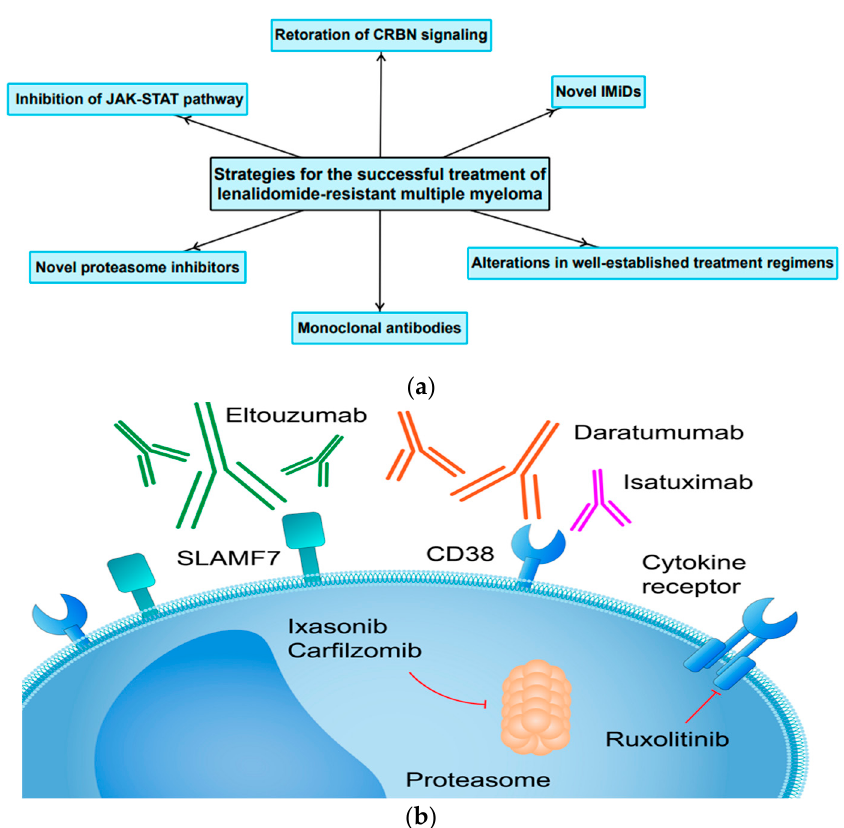
Figure 4. ( a ) The most important treatment strategies and future perspectives for the successful treatment LEN-resistant MM. ( b ) Molecular targets for novel agents successfully implemented in the treatment of